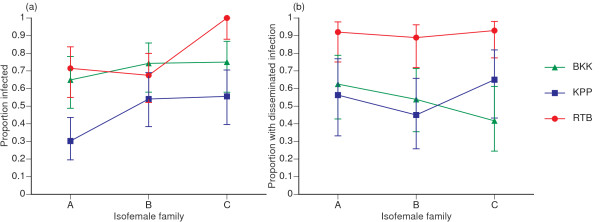
Effect of family × isolate interactions on virus infection and dissemination. (a) The proportion of mosquitoes with a midgut infection and (b) proportion of infected mosquitoes with a disseminated infection as a function of mosquito families and virus isolates. In both panels, three isofemale families from a Ratchaburi population (A, B, and C) are ranked on the x-axis according to the mean proportion of infected mosquitoes across isolates. Each line represents a single virus isolate (BKK: Bangkok; KPP: Kamphaeng Phet; RTB: Ratchaburi). Vertical bars show the confidence intervals of the proportions. Crossing lines give an indication of family × isolate interactions.